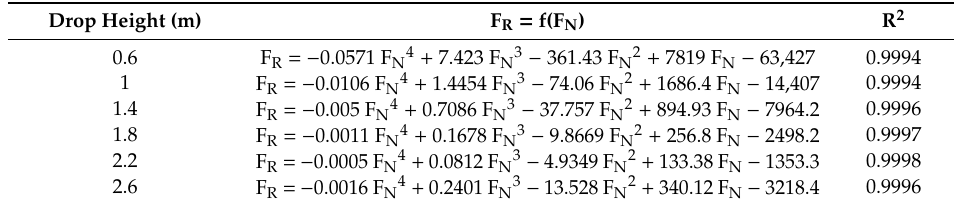
Figure 16. Correlation between the impact force F R and the tensile force F N for the drop hammer weight of 100 kg. Table 7. Correlation between the impact force F R and the tensile force F N for the drop hammer weight of 60 kg.